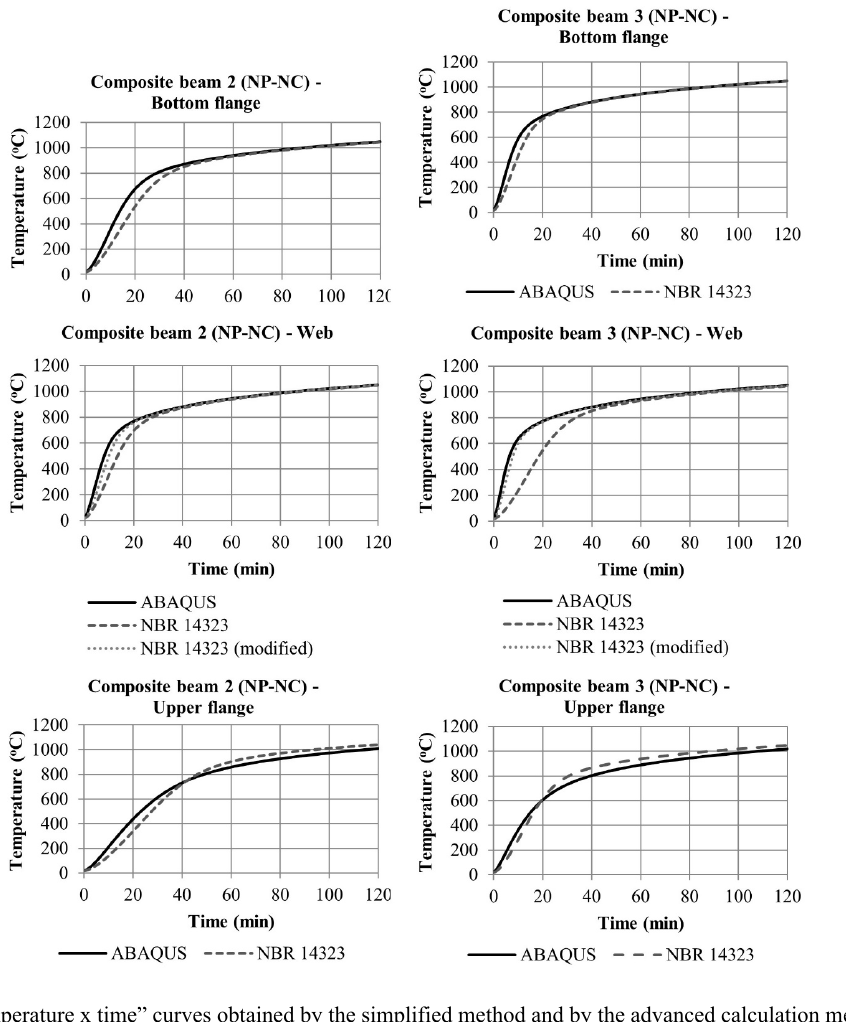
Figure 10. “Temperature x time” curves obtained by the simplified method and by the advanced calculation method for the profiles of composite beams 2 (NP-NC) and 3